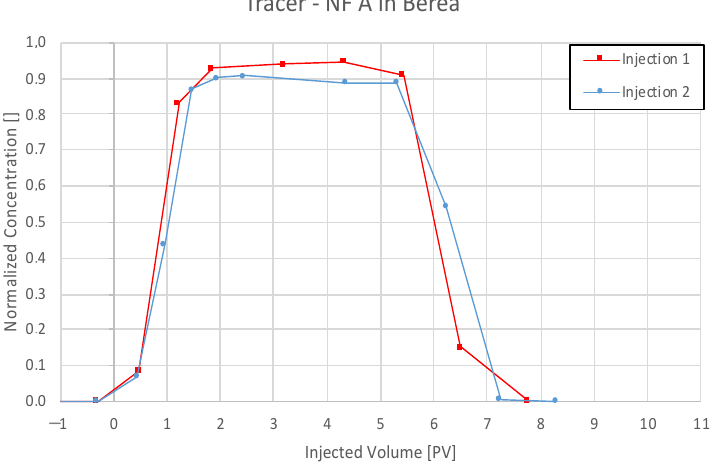
Figure 8. A comparison of tracer concentration history indicates a similar tracer breakthrough at ~0.95 PV (50%) for both injection steps and slightly longer retention in the second injection. Table 7. Adsorption results following mass balance calculation for NF A in Berea and The obtained effluent histories were used to calculate the mass of produced nanofluid and tracer by integration, and the results are presented in Table 7. The ratio of produced over injected tracer is ~85%, indicating a baseline value for recovery of an inert chemical. The recovery of NF A in the second injection step is almost at that level (79.3%), whereas it is only 22.5% of the first injection. These results lead to a specific adsorption of